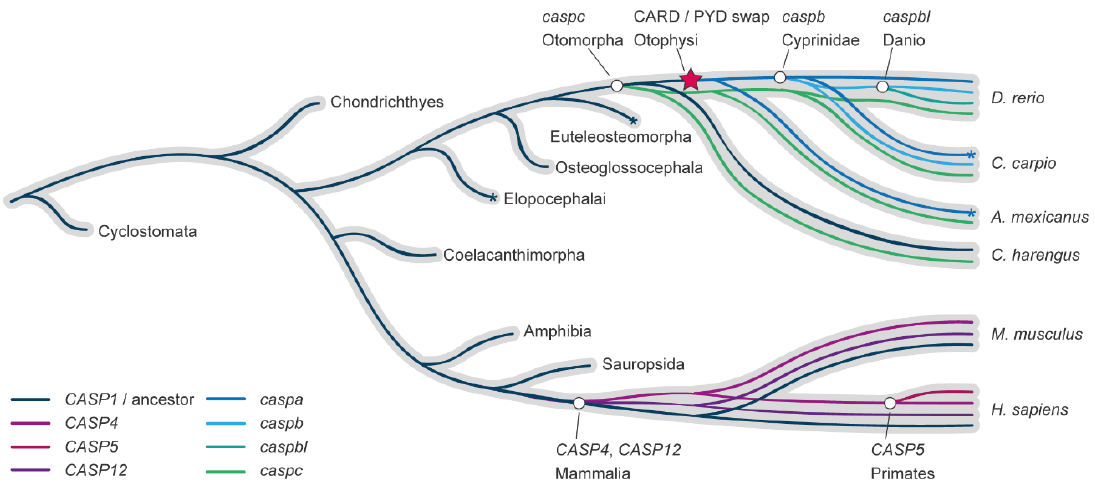
Figure 2. Evolutionary model of the caspase-1-like family in fish and mammals. Reconciliation of the caspase-1-like gene subfamily evolution inside of the species evolution (grey). Gene duplication events are depicted with a white circle symbol, indicating in the label the last common ancestor in which the duplication has been found. The CARD / PYD prodomain swap is indicated with a red star. Asterisks indicate gene expansions in lineages outside of the scope of this study.